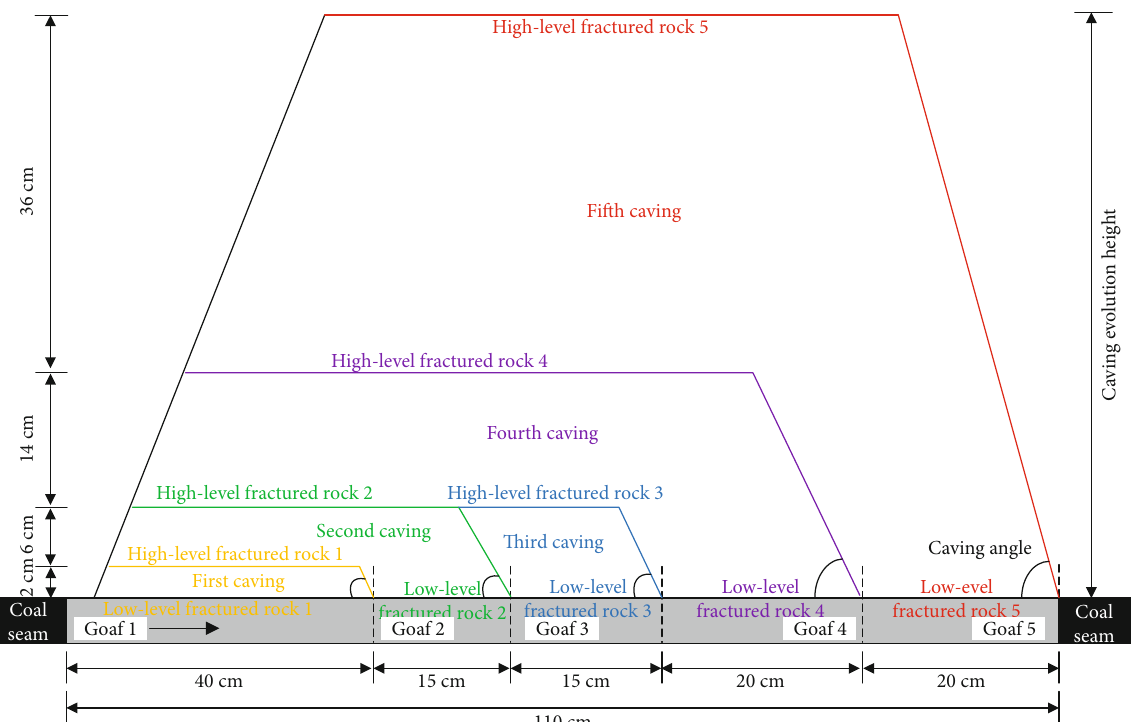
Figure 4: Spatial distribution of roof caving during advancement of the mining